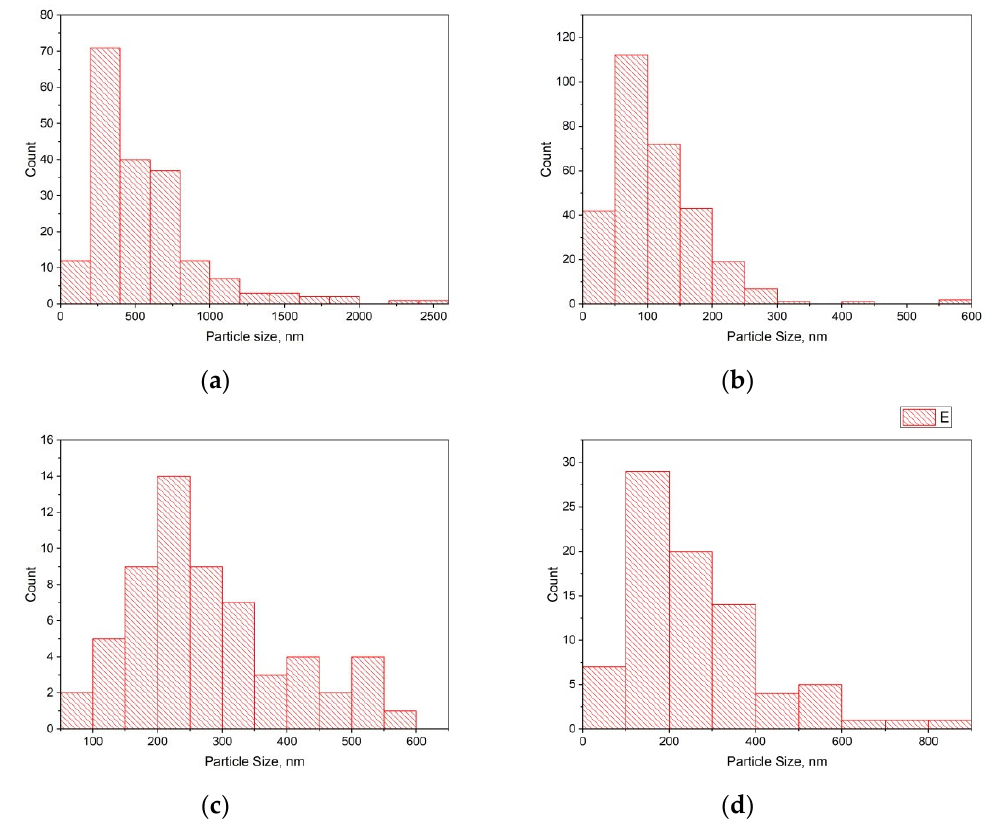
Figure 4. Distribution of metal particles by size on the catalyst: ( a ) GO_Ag 10%, ( b ) GO_Ag 20%, ( c ) MWCNT_Ag 10%, ( d ) MWCNT_Ag 10% Pd 10%. ( c ) MWCNT_Ag 10%, ( d ) MWCNT_Ag 10% Pd